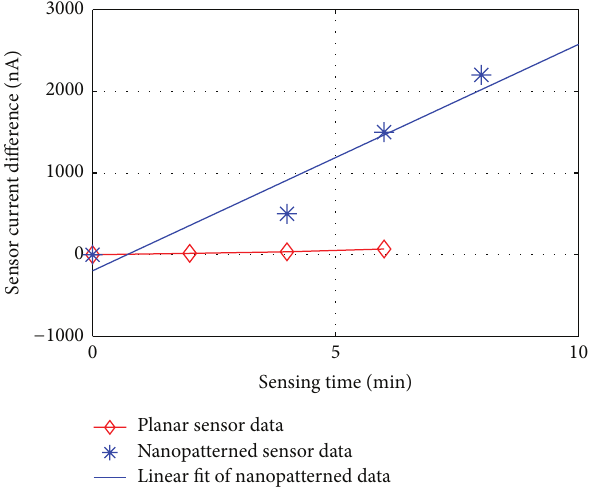
Figure 15: Comparison of nucleic acid hybridization detection efficiency for planar and nanopatterned